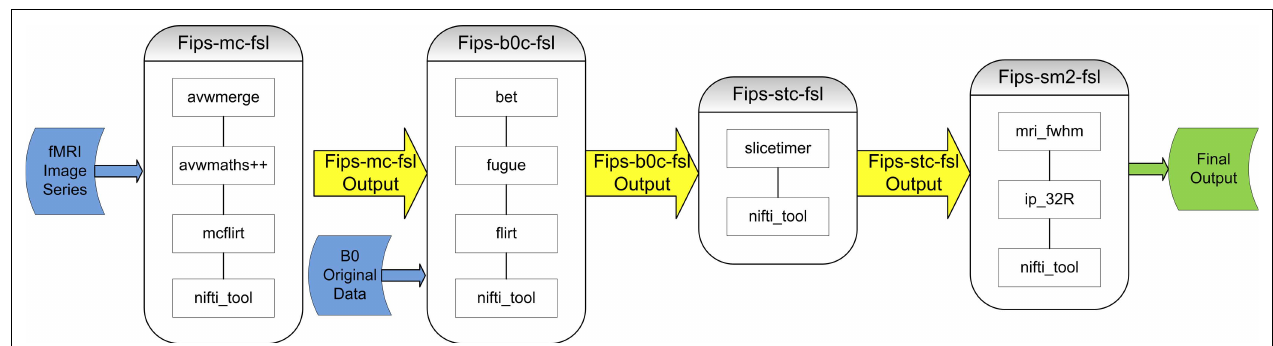
FIGURE 4 | fMRI PreProc data preprocessing workfl ow. Original data inputs colored blue, intermediate derived data colored yellow, fi nal derived data output colored green. Workfl ow transform modules Fips-mc-fsl, Fips-b0c-fsl, Fips-stc-fsl, and Fips-sm2-fsl contains variable numbers of sub-transform steps to produced intermediate and fi nal derived